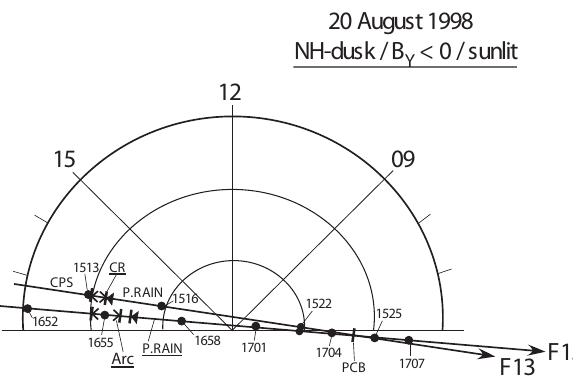
Fig. 12. Two DMSP F13 tracks across the polar cap in the Northern Hemisphere shown in MLT/MLAT coordinates. The event category is NH-dusk/ B y < 0 (sunlit). The following intervals are marked: (i) 15:13–15:25UT and (ii) 16:52–17:07UT. Precipitation regimes are marked along the